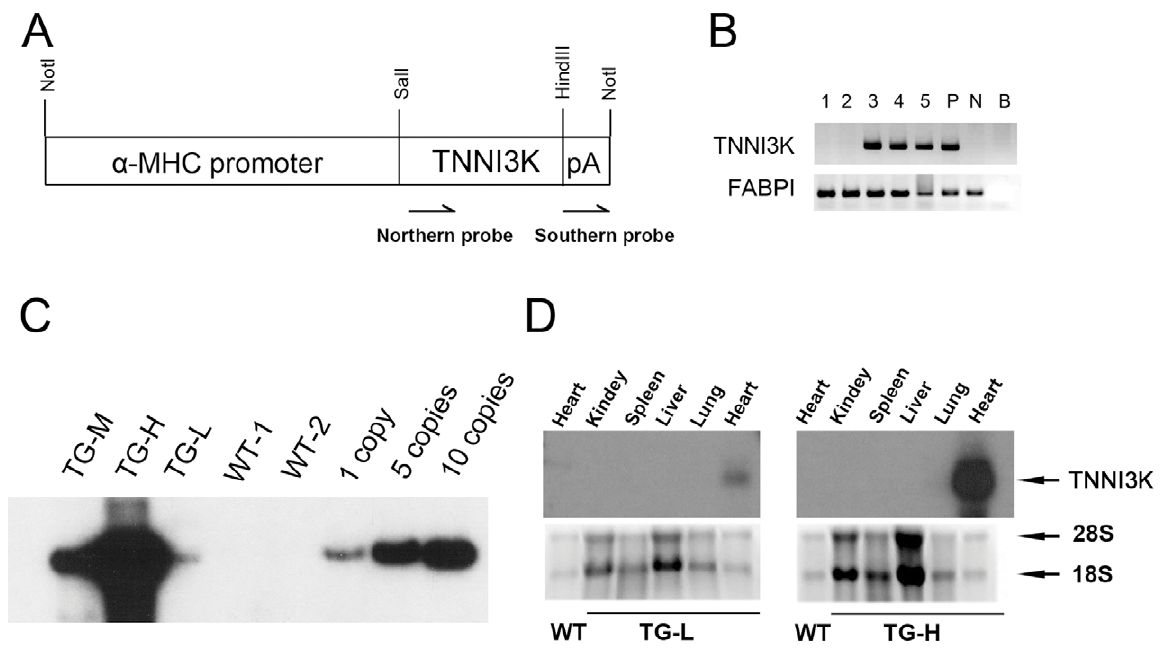
Figure 2. Generation of cardiac-specific TNNI3K transgenic mice. (A), Schematic of the TNNI3K transgene that was constructed with the a - MHC mouse promoter. pA: human growth hormone polyA sequences The positions of the Southern probe and northern probe were shown below the construct; (B), PCR genotyping of TNNI3K transgenic mice. 1–5: transgenic mice. P: positive control, wild-type mouse genomic DNA mixed with linearized transgenic fragment. N: negative control, wild-type mouse genomic DNA. B: blank, none DNA template. FABPI gene was amplified as internal control. (C), Southern blot analysis of wild-type and TNNI3K transgenic mice. Tail genomic DNA was digested with EcoRI and probed with hGH polyA sequence. Hybridization signals were present only in transgenic positive mice. Transgenic copy number was determined from the gray density against standard curve. 1 copy -10 copies: transgenic copy standards. (D). Northern blot analysis of RNA isolated from multiple tissues of the transgenic TG-L and TG-H lines. Hybridization signals were present only in the heart of transgenic mice. The RNA isolated from the heart of wild-type